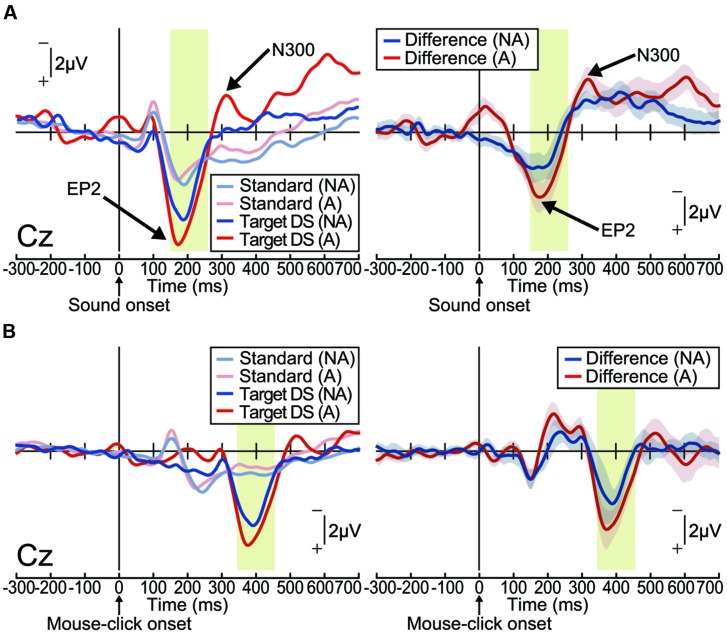
Delayed auditory feedback elicited an enhanced-P2 (EP2) and N300 (Experiment 2). Grand-averaged ERP waveforms computed by (A) auditory stimulus onset or (B) action (mouse-click performed by participant) onset. (A) Left: ERPs elicited by passive presentation of a delayed (150 ms) auditory stimulus (non-action condition; NA) or elicited by the mouse-click action performed by the participant (action condition; A; n = 16). Right: differential (target – standard) ERP waveforms. Shaded (blue or red) areas represent SEM. The EP2 (positive peak around 200 ms) was apparent in both conditions [non-action: t(15) = 4.89, p < 0.001, effect size r = 0.79; action: t(15) = 5.99, p < 0.001, effect size r = 0.84]. The N300 (negative peak around 300 ms) followed the EP2 [non-action: t(15) = 4.30, p < 0.001, effect size r = 0.74; action: t(15) = 4.71, p < 0.001, effect size r = 0.77]. (B) Left: ERPs elicited by passive presentation (NA) of a delayed (150 ms) auditory stimulus or by a mouse-click performed by the participant (A; n = 16). Right: differential (target – standard) ERP waveforms. Shaded (blue or red) areas represent SEM.